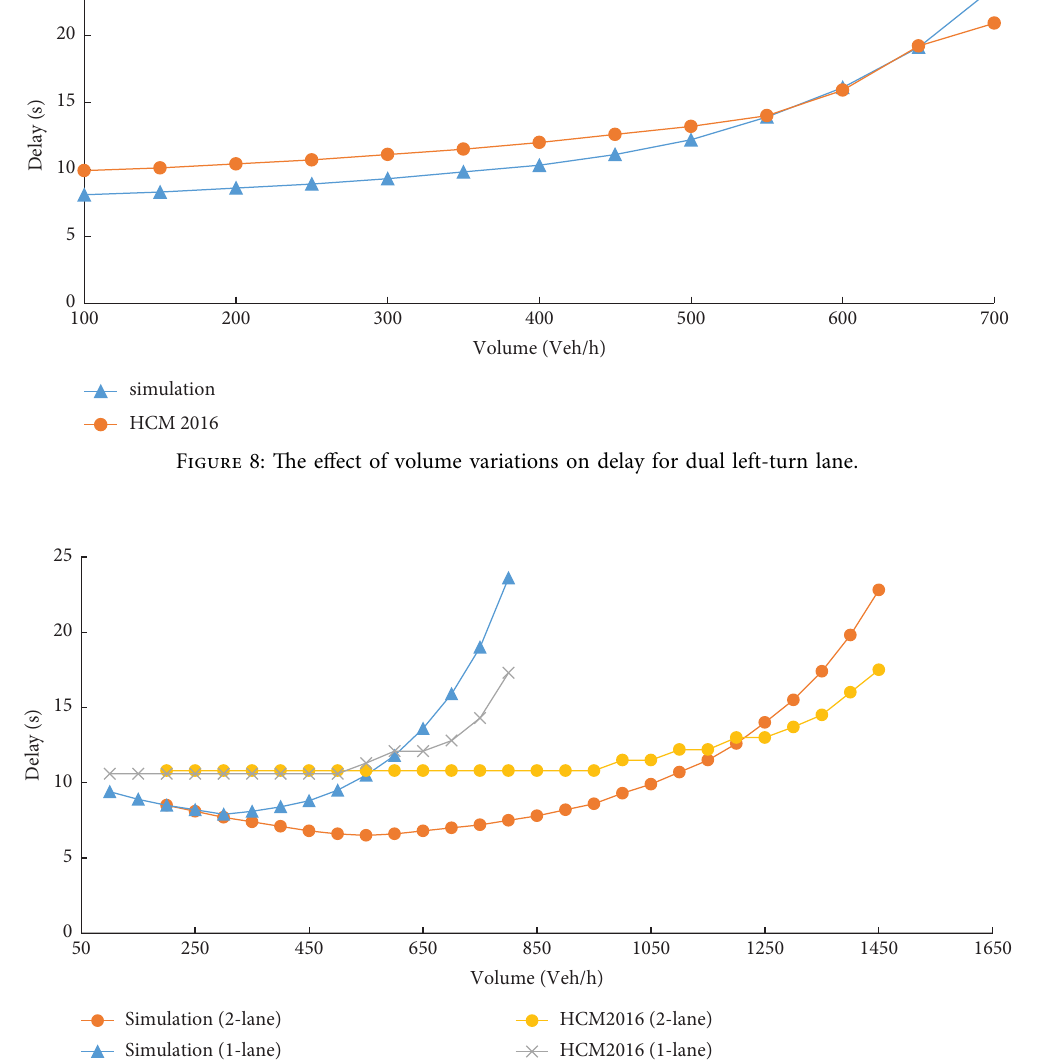
Figure 9: Delay variations of the efect of changing trafc scenarios in single and dual right-turn lanes.